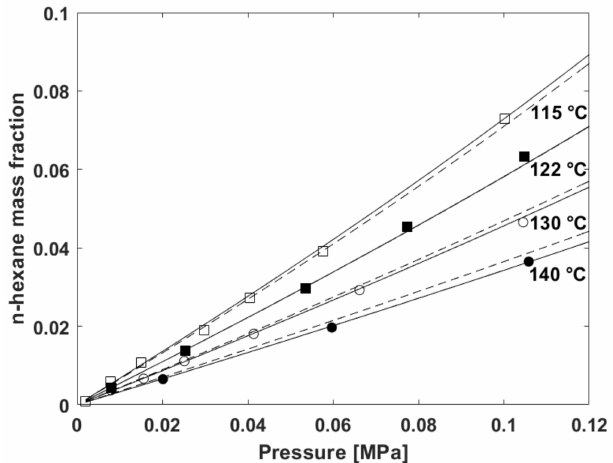
Figure 1. Experimental sorption isotherms of n-hexane vapor in V8880 at 115 ◦ C (white squares), 122 ◦ C (black squares), 130 ◦ C (white circles), and 140 ◦ C (black circles). Results of simultane- ous best fitting of data by using Non Random Lattice Fluid (NRLF) model for mixtures with a temperature-independent binary interaction parameter are reported as dotted lines (best fitting value of k 12 = − 0.0754). Results of simultaneous best fitting of data by using NRLF model for mixtures using a k 12 linearly dependent on temperature are reported as continuous lines (best fitting values of the two parameters are k 12, a = − 0.1505 and k 12, b = 1.90 × 10 − 4